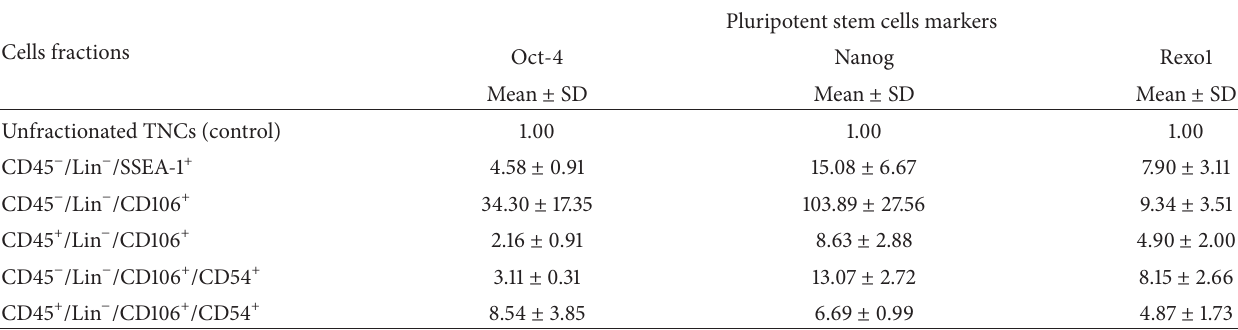
Table 2: Quantitative real time RT-PCR analysis of mRNA expression for genes related to pluripotency in purified populations of rat BM- derived